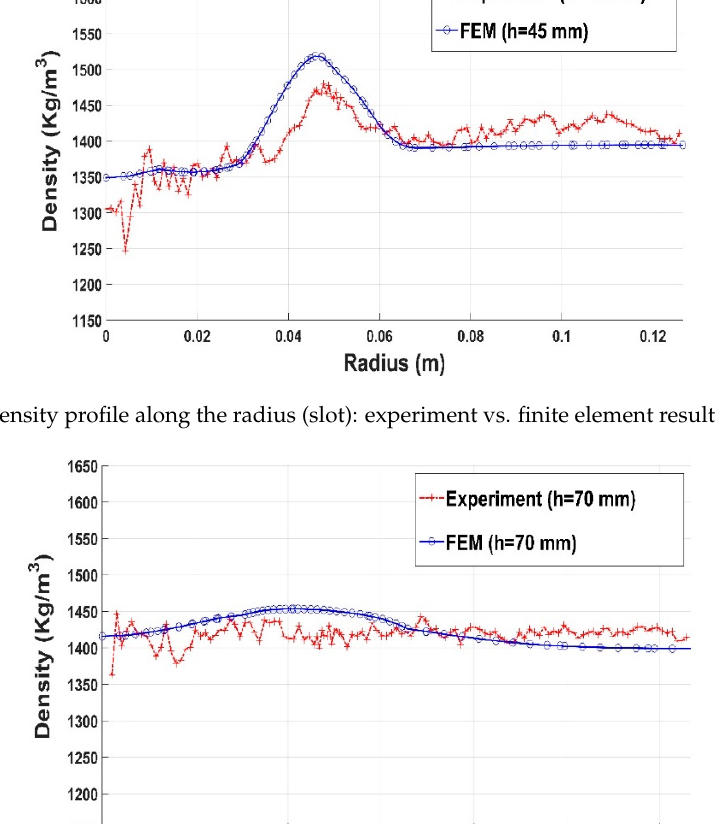
Figure 30. Density profile along the radius (slot): experiment vs. finite element result (h = 30 mm).